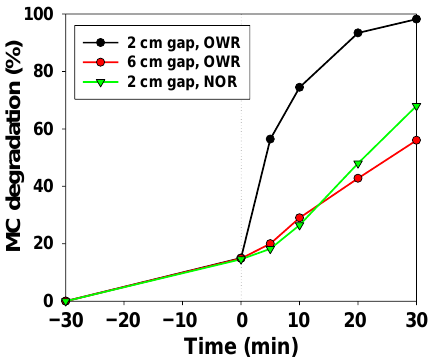
Figure 3. MB degradation on the open-wide-reactor (OWR) and narrow-open-reactor (NOR), plac- ing the UV-lamp at different gaps.